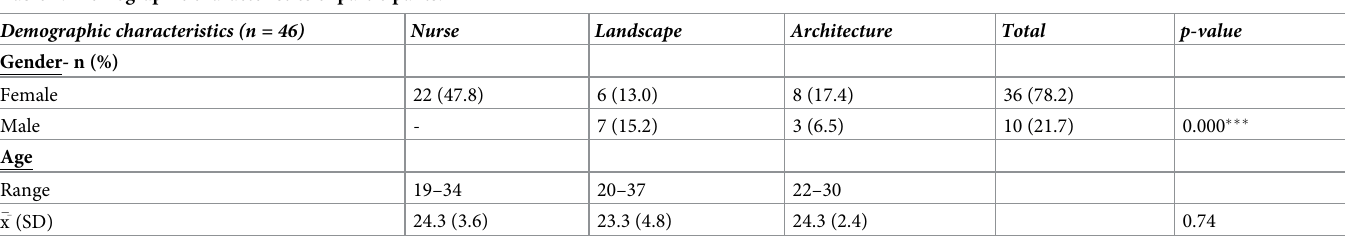
Table 1. Demographic characteristics of participants.